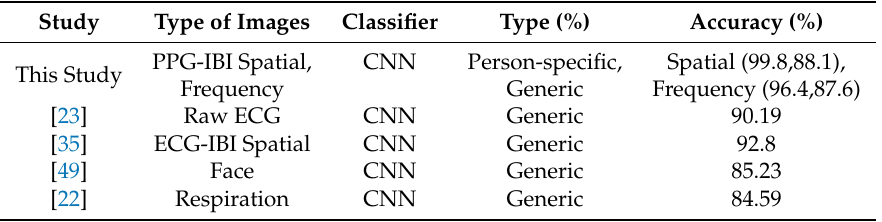
Table 10. Comparing the findings of this study with other